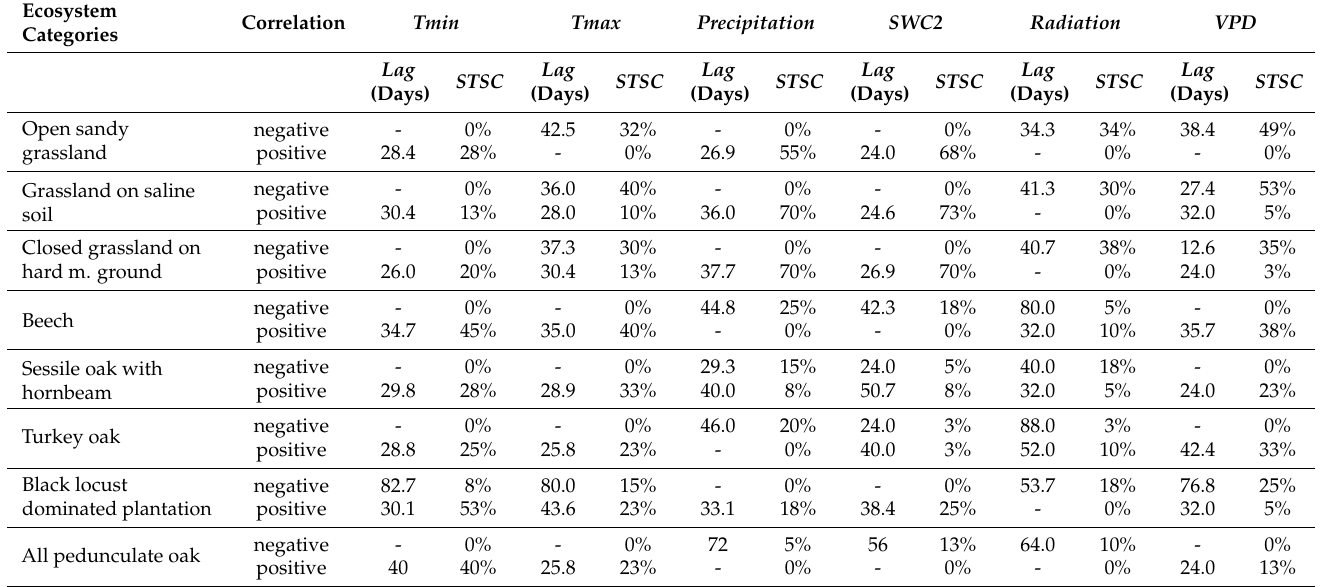
Table 3. The average length of the time lags ( lag , expressed in a number of days) between NDVI and the used climate variables for the time lags with the most significant R and the share of time between 25 Jan and 10 Dec (forty 8-day periods; the peak of the winter was discarded to minimize the snow effects) when the correlation was highly significant ( p ≤ 0.01; STSC –share of time with significant correlation), according to the sign of the